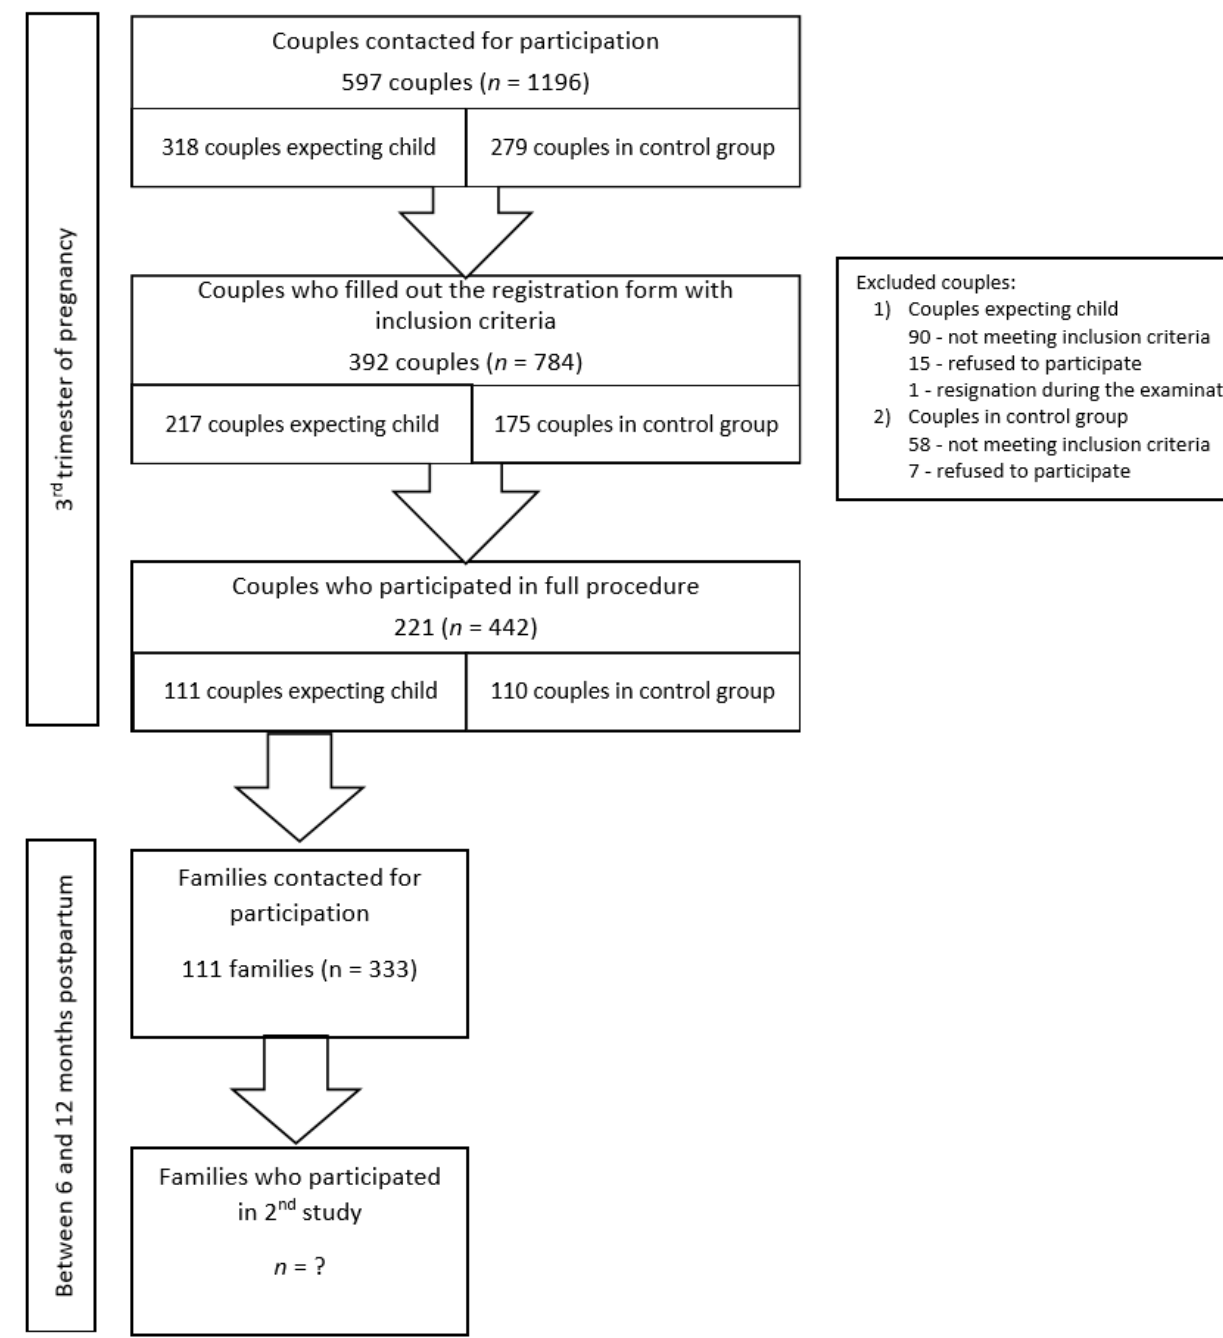
Figure 2. Flow chart of the number of participants in the first (expectant and non-expectant couples) and the second (between 6 and 12 months postpartum)